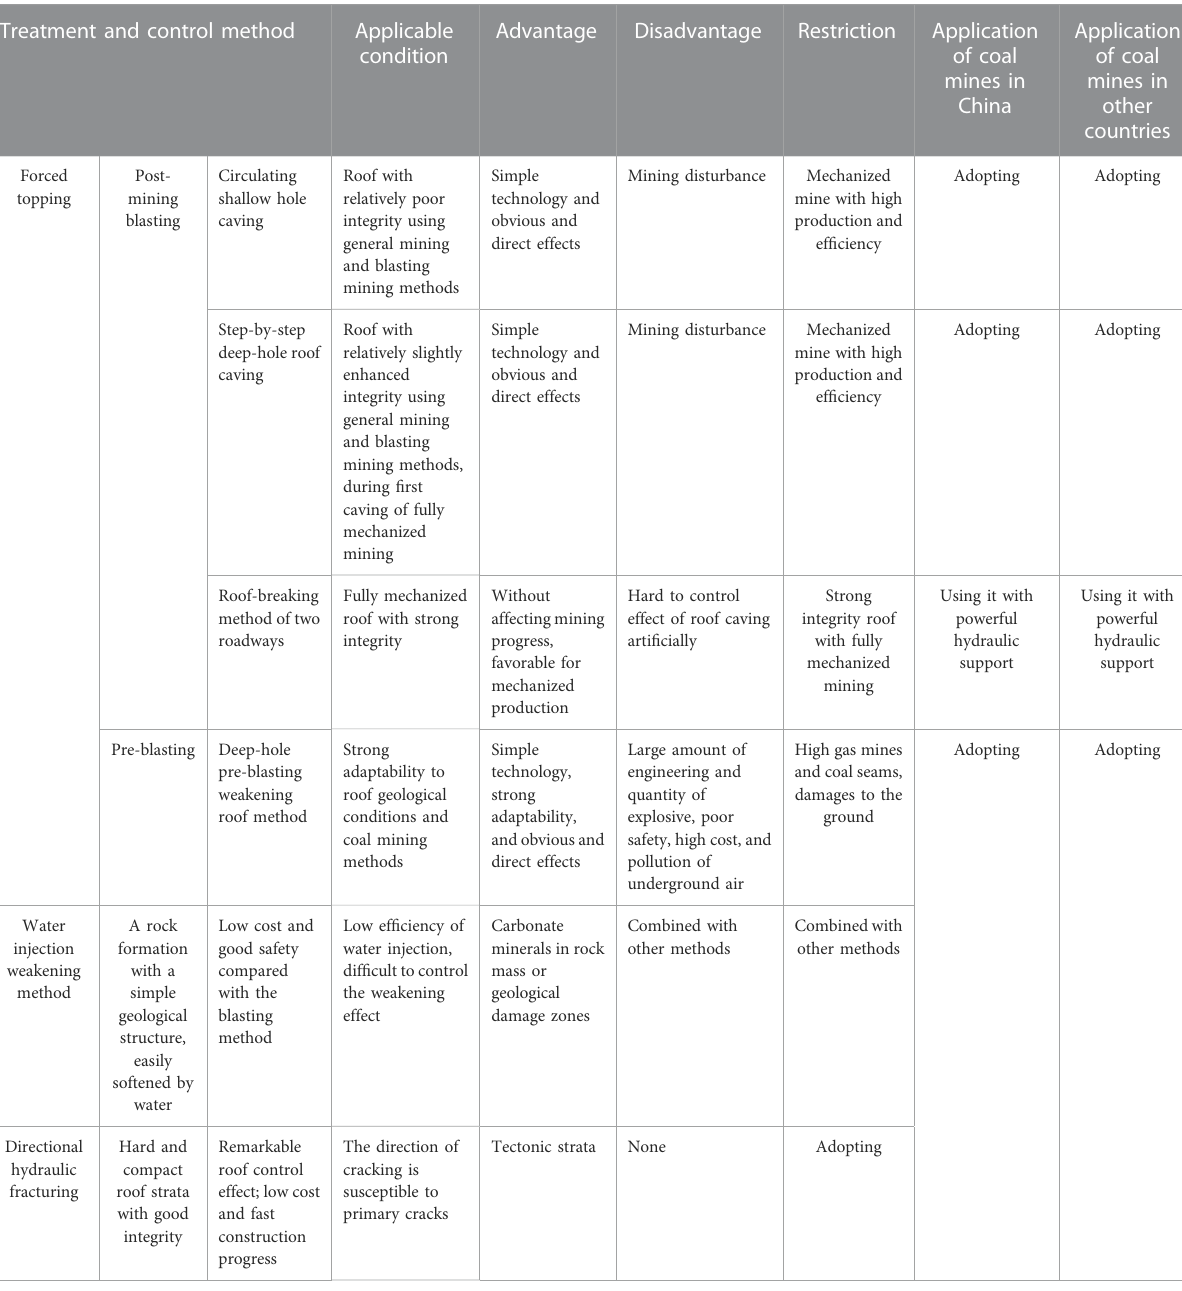
TABLE 1 Comparison of control methods for hard and dif fi cult roof